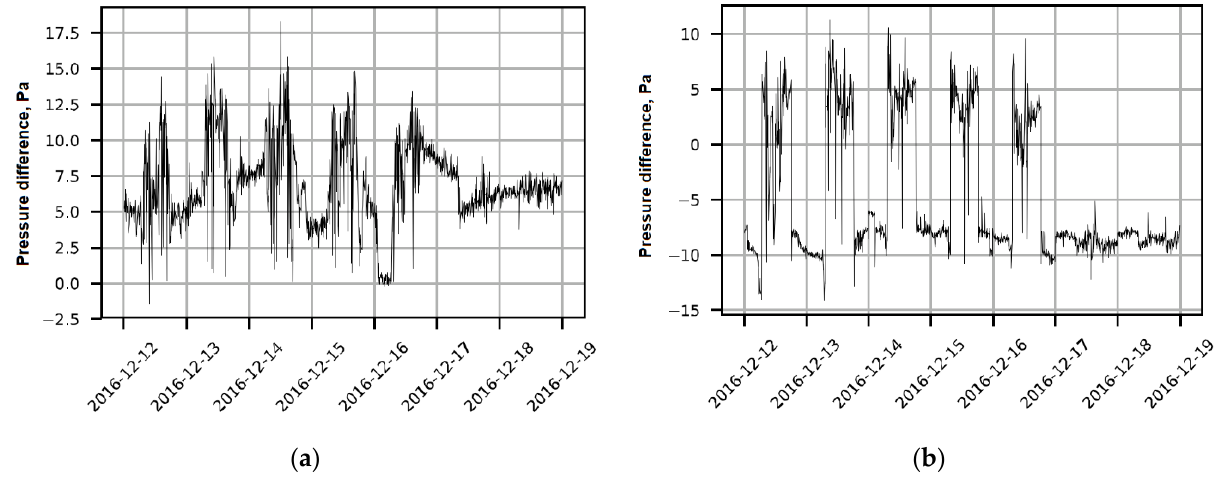
Figure 3. Air pressure difference over the exterior wall. ( a ) Measurements showing overpressure conditions with higher values during weekdays; ( b ) fluctuation between under- and overpressure.